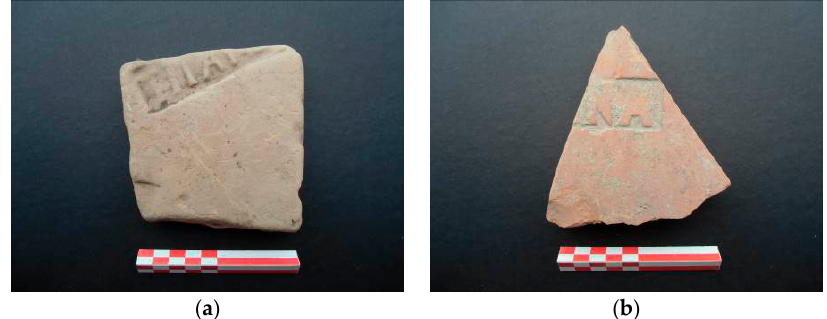
Figure 19. Fragments of Pansiana tiles found in Lago Tramonto, Gambulaga, Portomaggiore (FE, Italy): ( a ) Incipit of the stamp TIPAN [siana]; ( b ) Explicit of the stamp NA [Tipansia] (photo by Giovanna Bucci).